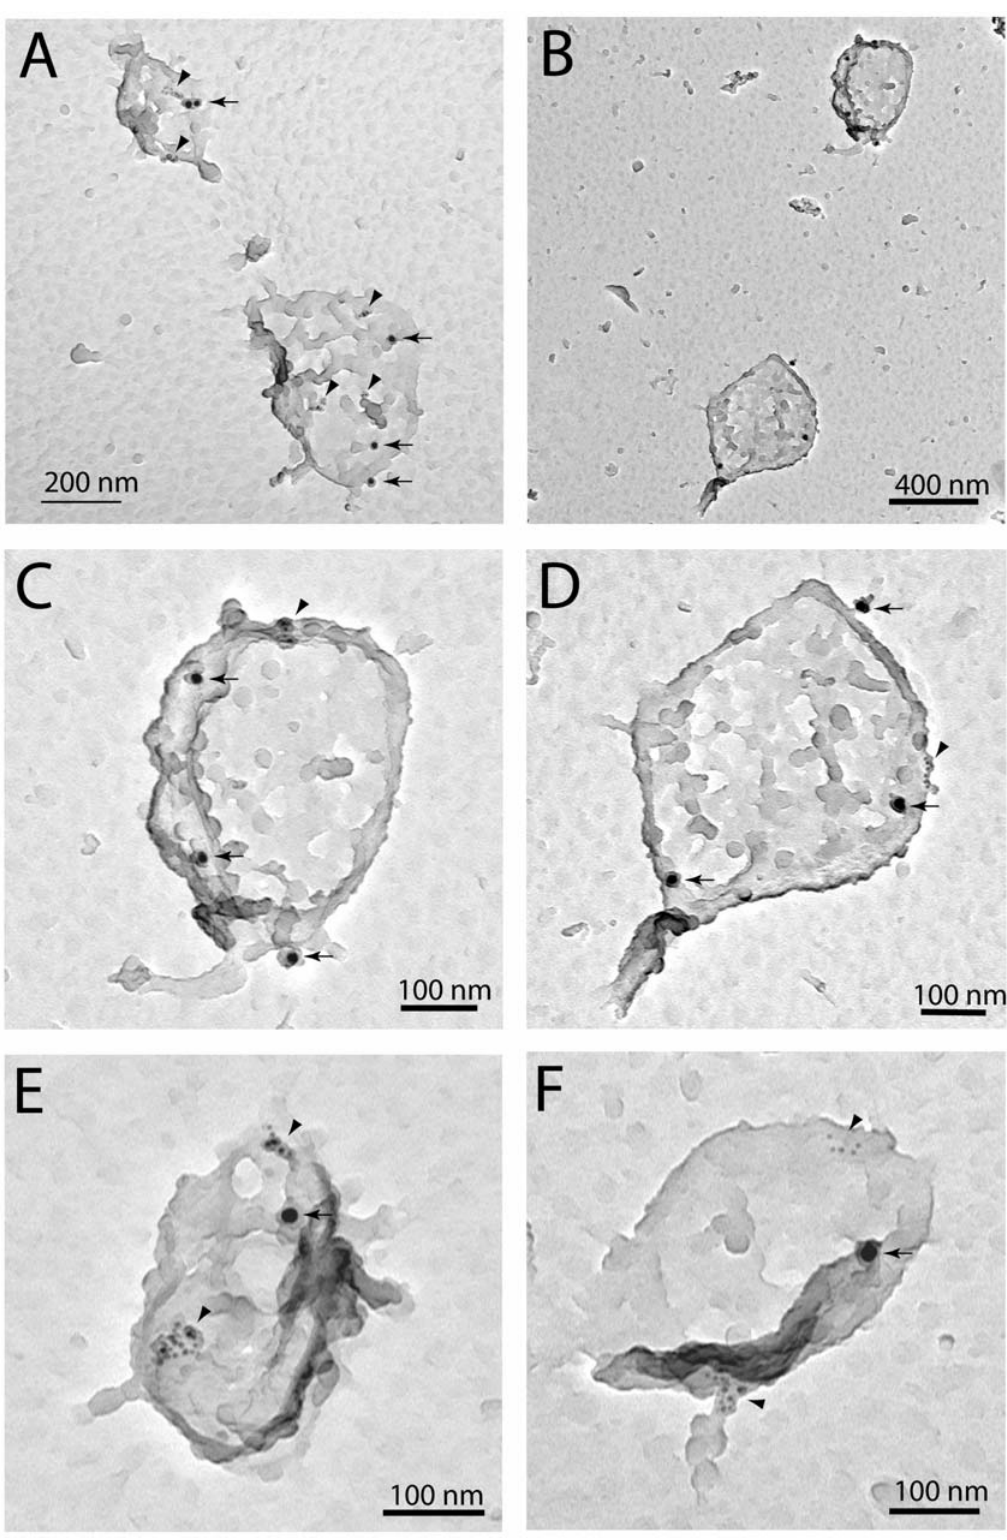
Figure 4. Localization of insulin receptor and caveolin-1 in endosomes by immuno-gold electron microscopy. Isolated adipocytes were incubated with insulin at 100 nM for 10 min. Cells were then homogenized and the endosomal fraction isolated. Endosome vesicles were attached to grids, immunogold-labeled against caveolin-1 (6 nm gold particles) and the insulin receptor (15 nm gold particles), lyophilized and sputtered with a 2-nm tungsten film before examination by transmission electron microscopy. C and D are blow-ups from B; arrowheads indicate patches of caveolin- 1 labeling; arrows indicate insulin receptor labeling. One experiment of three with similar results is illustrated.